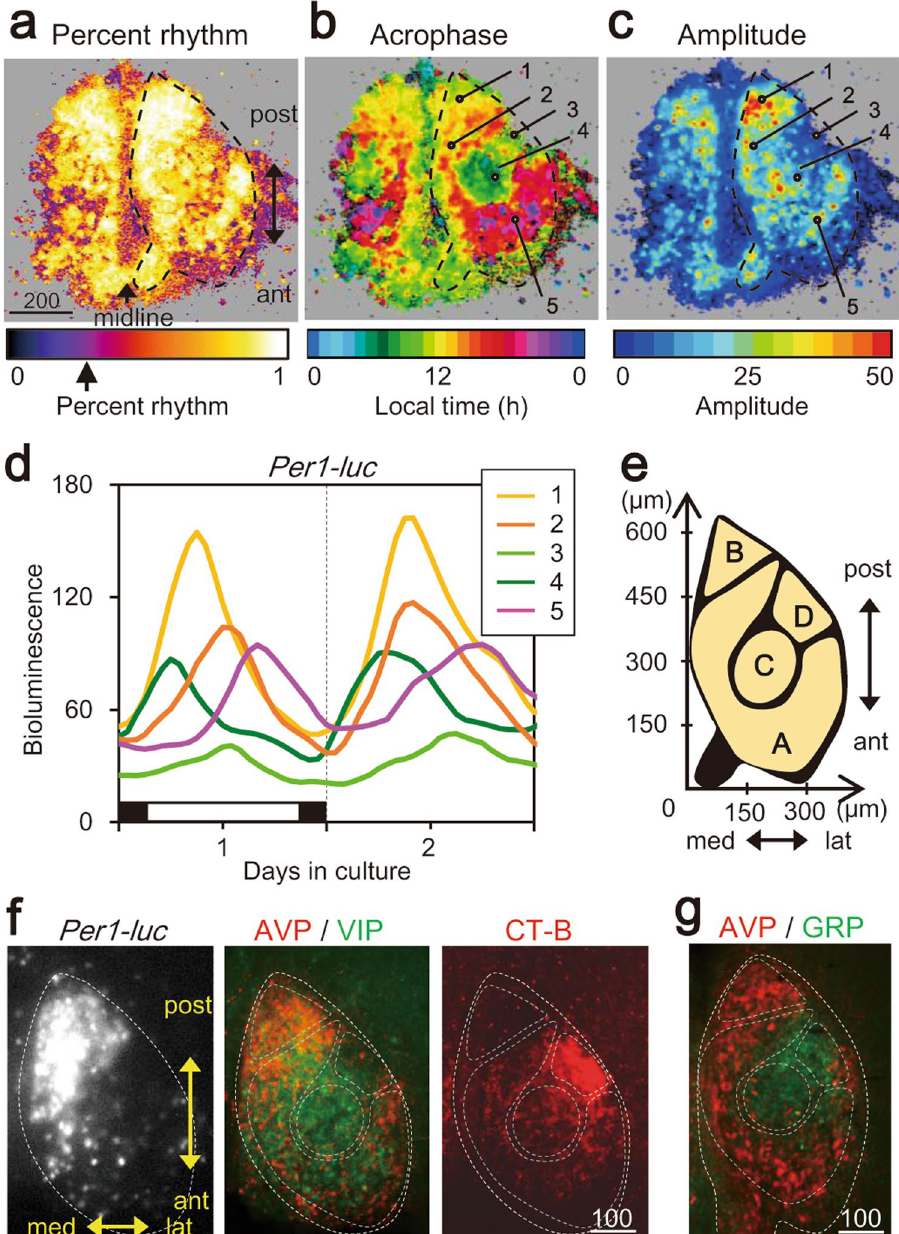
Figure 3. Regional specificities of circadian Per1-luc rhythms. ( a , b , c ) Pixel-level images of the percent rhythm ( a ), circadian peak ( b ) and rhythm amplitude ( c ) are illustrated throughout an SCN slice on the culture day 1. Color bars indicate the level of significance with an arrow indicating a significance level of P = 0.01 ( a ), local time ( b ) and height of amplitude ( c ). The pixels with lower bioluminescence than the background level were shown in grey. The pixels in which a significant circadian rhythm was not detected by percent rhythm test (arrow in a) are shown in black in b and c. A dashed trace line in each panel indicates the margin of the right SCN determined by immunohistochemical analysis. Scale bar, 200 μ m. ( d ) Bioluminescence rhythms in five ROIs (circle with a 3-pixel diameter) shown in the panel b and c. ( e ) Based on panels a, b and c, the four SCN regions of distinct circadian characteristics are schematically drawn in the right SCN. ( f ) Image of bioluminescence (left), immunofluorochmistry of AVP and VIP double staining (middle), and of the retinohypothalamic projections visualized by Alexa 594 conjugated cholera toxin subunit B (CT-B, right) of an SCN slice in Per1-luc mouse exposed to LD18:6. The CT-B and bioluminescence images were taken at 13:00 and 18:00, respectively on the day of slice preparation. The slice was fixed at 16:00 on the 6th day in culture. Margin of the SCN and the regions A-D are shown by broken trace lines. V, third ventricle; OC, optic chiasm. ( g ) Image of immunofluorochmistry of AVP and GRP. The SCN slice was fixed at 12:00 in